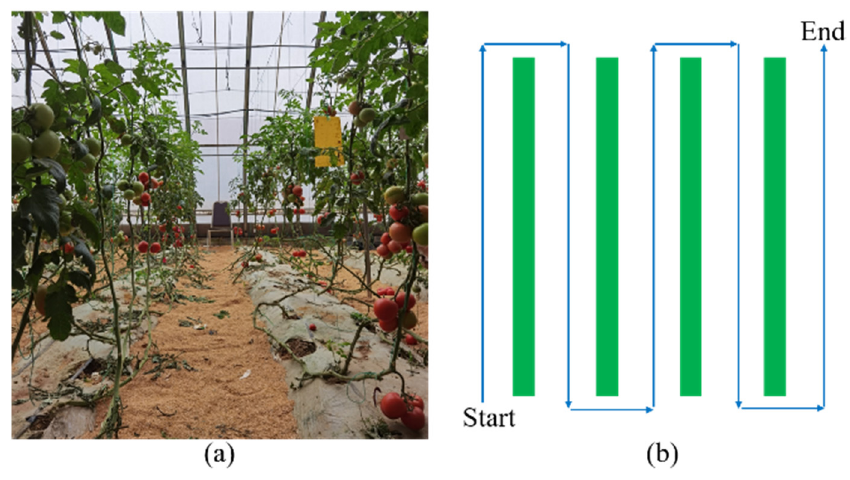
Figure 2. The ( a )actual and ( b ) schematic diagram of the greenhouse